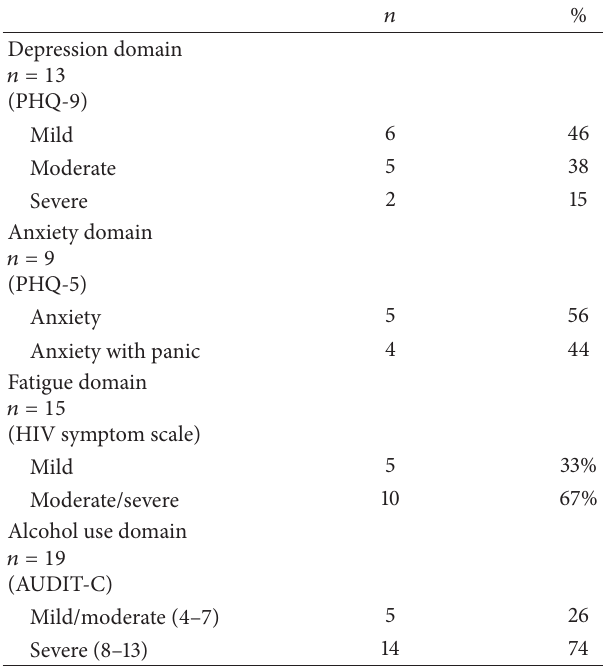
Table 2: Severity of disease found among participants in the first round of cognitive